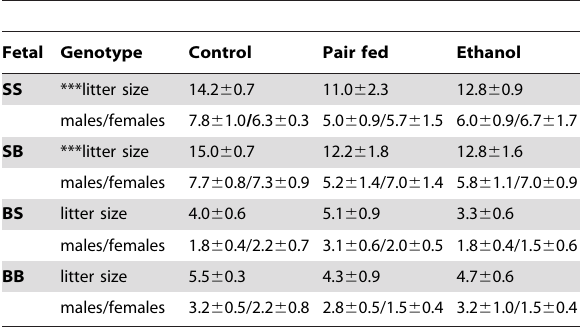
Table 1. Litter sizes and male/female ratios obtained from SD and BN litters and hybrid